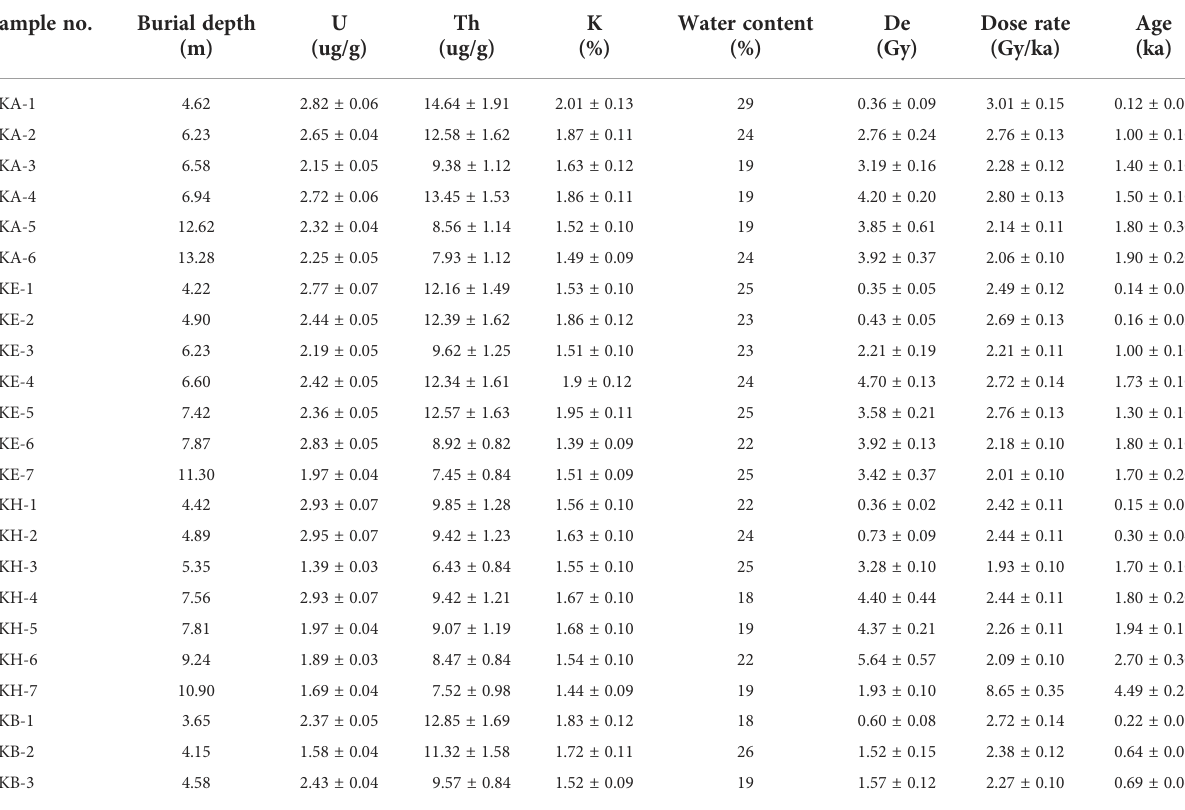
TABLE 2 OSL sample code, radionuclide concentrations, depth, water content and dose rates. Sample